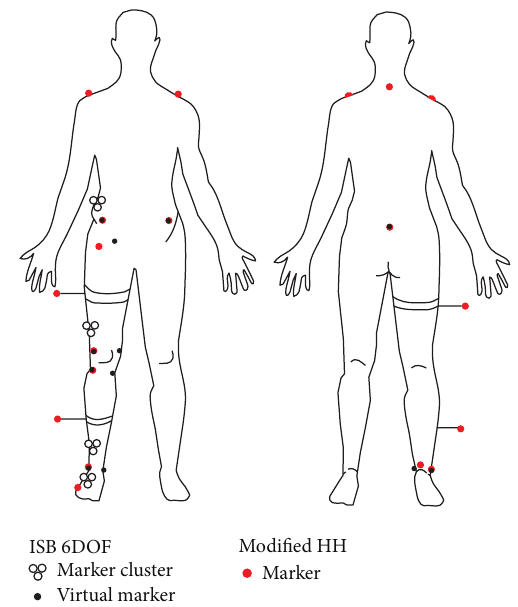
Figure 1: Marker locations for ISB 6DOF and HH sets. ISB 6DOF: triads of hollow circles—technical marker clusters, black, small dots—virtual markers; HH—red, big